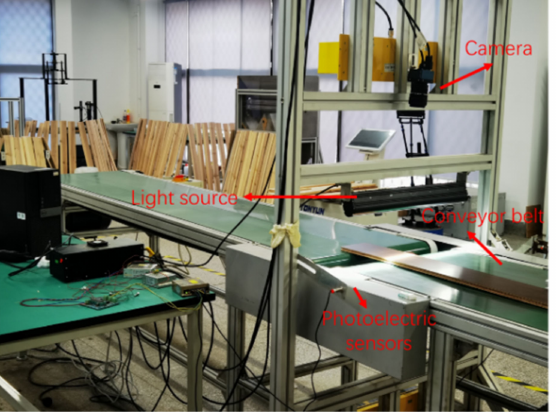
Figure 1. Image acquisition system to collect solid wood floor images.